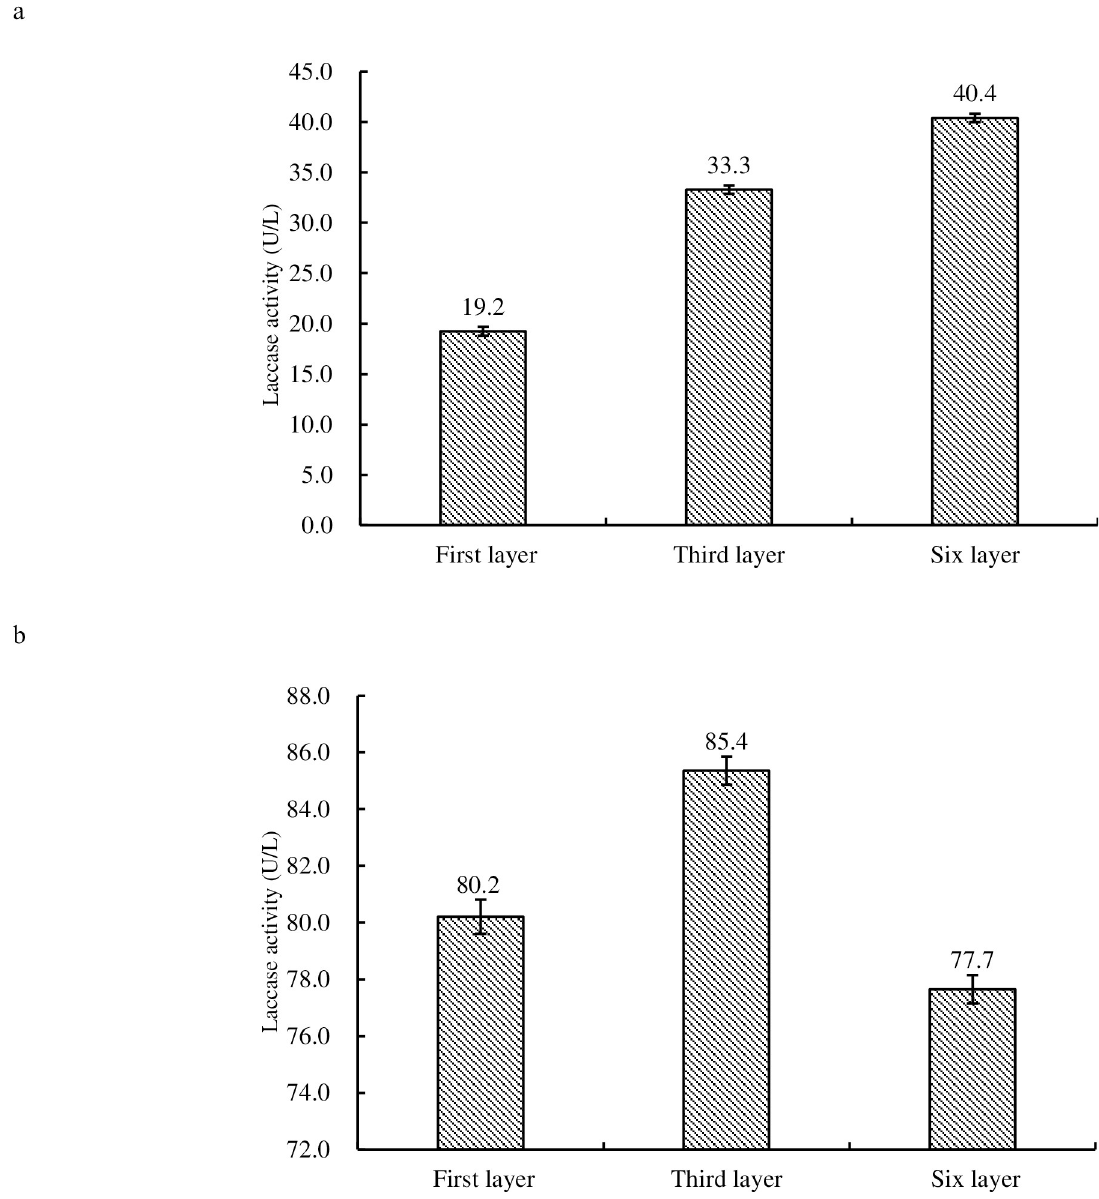
Fig 7. Comparison of laccase activity in budding fruiting bodies (7a) and mature fruiting bodies (7b) of 1 st , 3 rd and 6 th tier of H . marmoreus